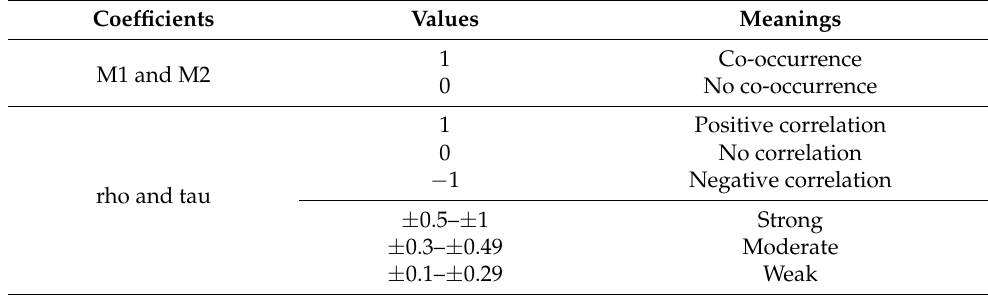
Table 1. Colocalization coefficient, its values and